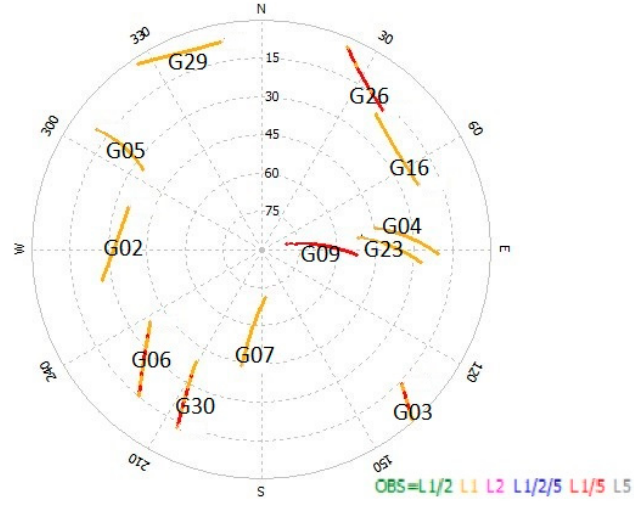
Figure 22. Huawei P30 Pro skyplot of GPS-only (third experiment).